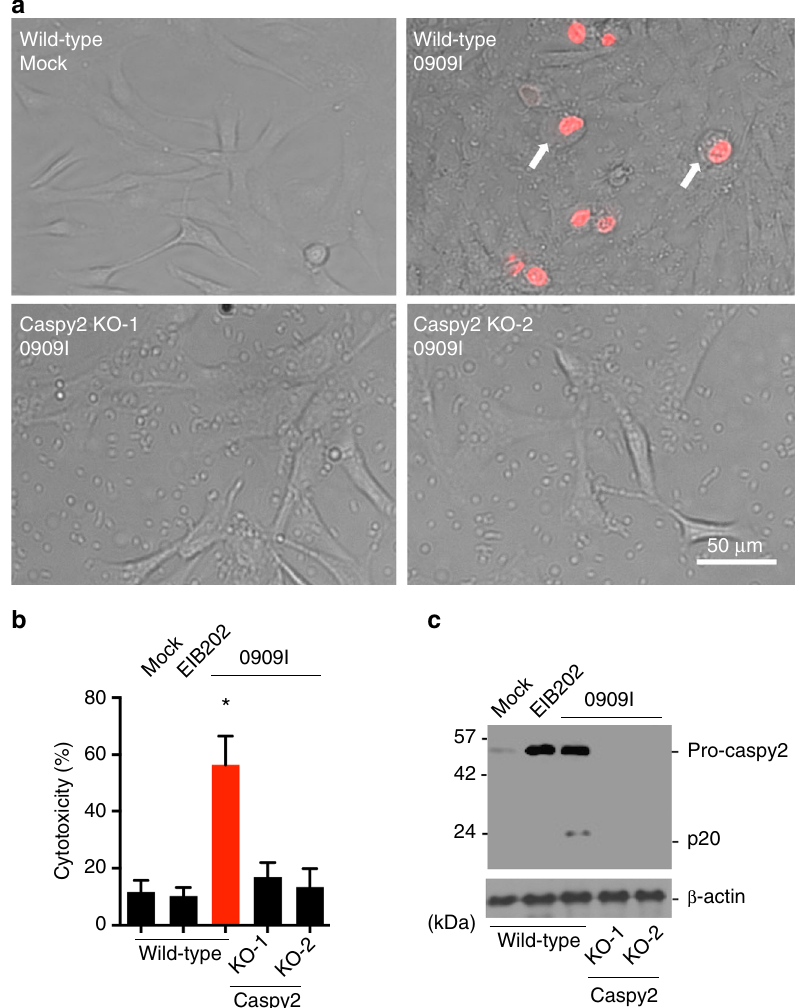
Fig. 2 Caspy2 plays a critical role in pyroptosis in zebra fi sh fi broblasts. a – c Wild-type and caspy2 -knockout (KO) ZF4 cells were infected with EIB202 or 0909I E. piscicida for 2 h at an multiplicity of infection (MOI) of 50, or left uninfected. a Images were taken as in Fig. 1d. Propidium iodide (PI) was added to detect the loss of plasma membrane integrity. Arrows signify cells with pyroptotic-like features. Scale bar, 50 µ m. b Supernatants from the indicated ZF4 cells were analyzed for cell death measured by lactate dehydrogenase (LDH) release. c Mixtures of cell lysates and supernatants were subjected to immunoblotting. ( a – c ) Results are representative of at least three independent experiments, and error bars denote the SD of triplicate wells. * p <